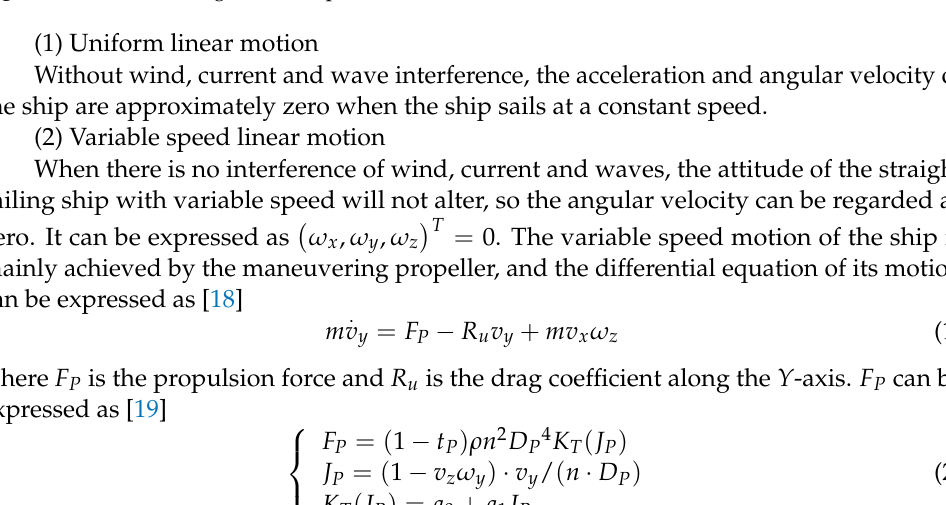
Figure 2. Schematic diagram of ship motion variables.